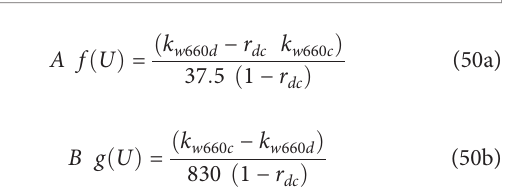
FIGURE 7 | Values of k w660 (upper panel, CO 2 ; lower panel, DMS) averaged in wind speed bins vs. 10-m neutral wind speed. The red diamonds are mean observed values, the x ’ s are from the wind speed power-law fi ts (48), the blue line is from (46) using A = 1.2 and B = 2.5, and the circles are means of values computed using COAREG36.